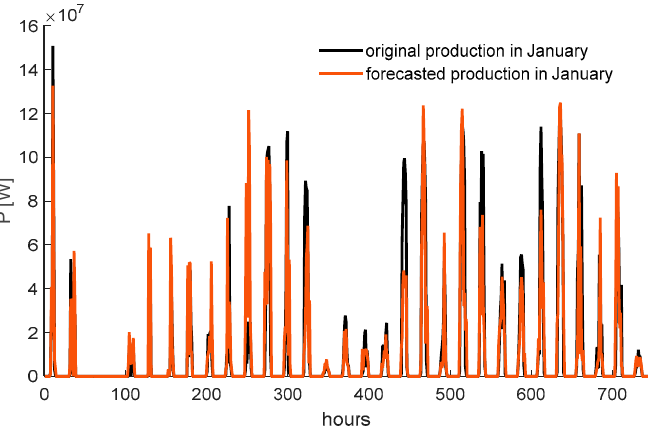
Figure 14. The original and forecasted electricity production from PV in January 2020. Table 13. Common metrics result for model SARIMA (1, 0, 1) × (0, 1, 1) 12